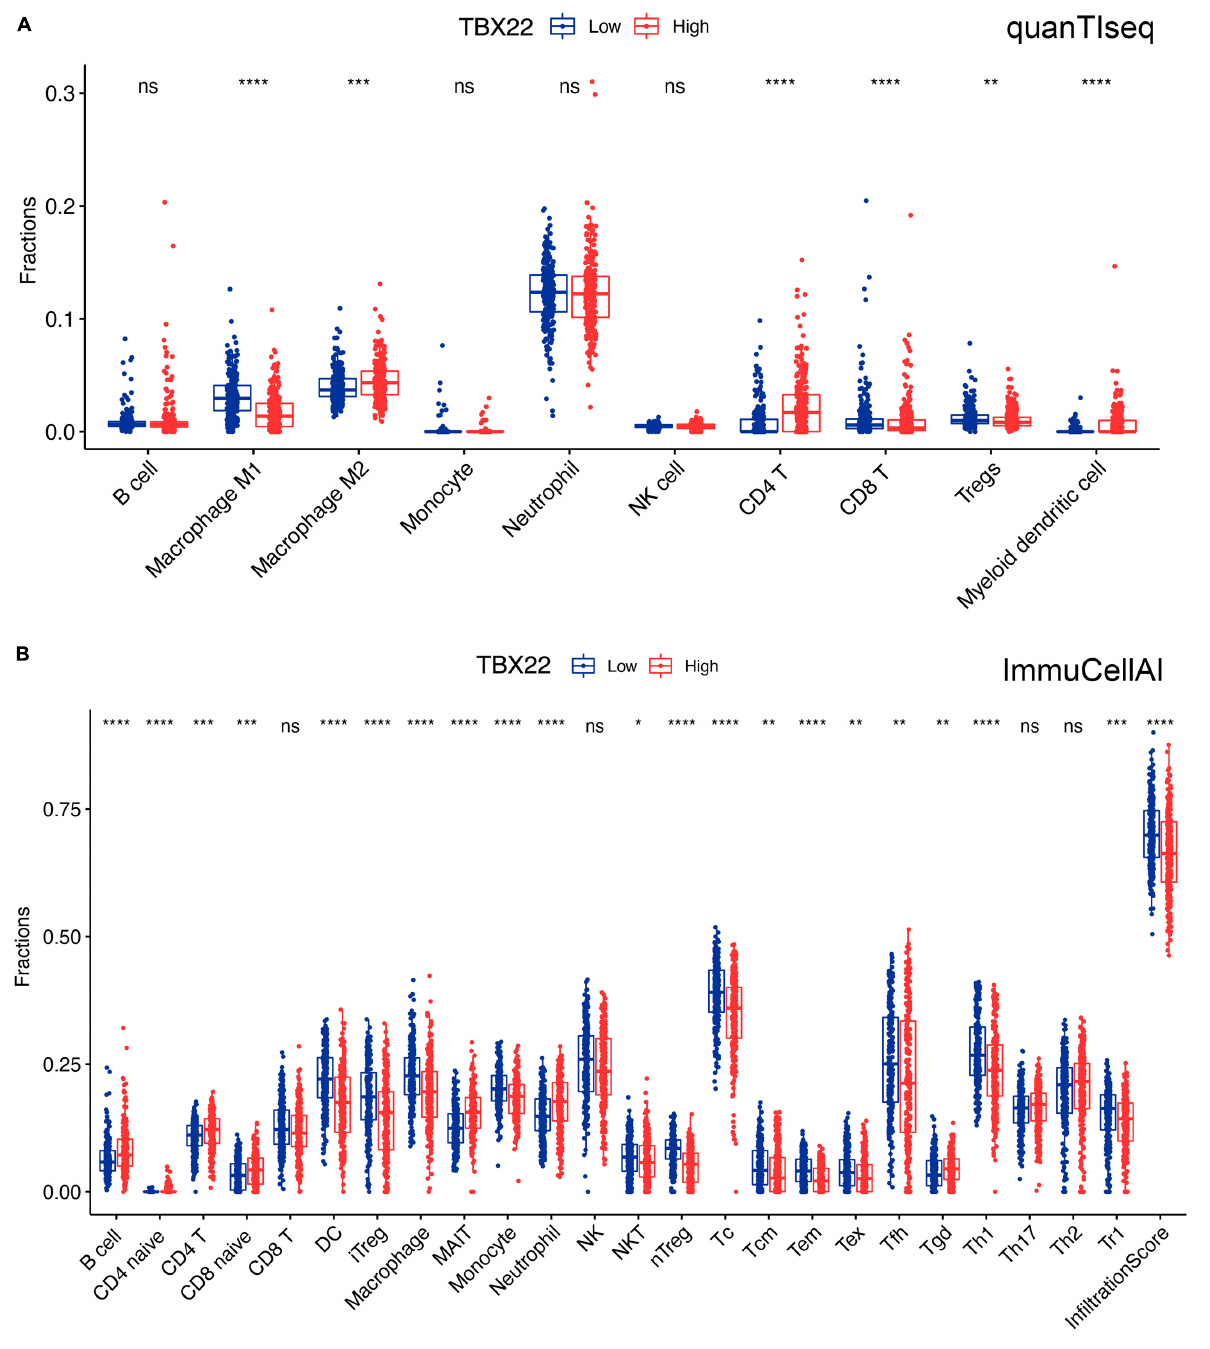
TME (Gentles et al., 2015; Orhan et al., 2020). As there